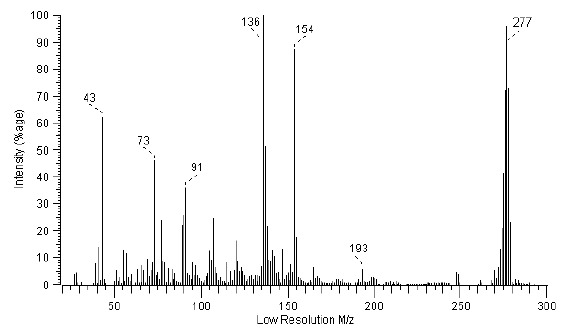
Figure 4. FAB-MS spectrum of compound 2